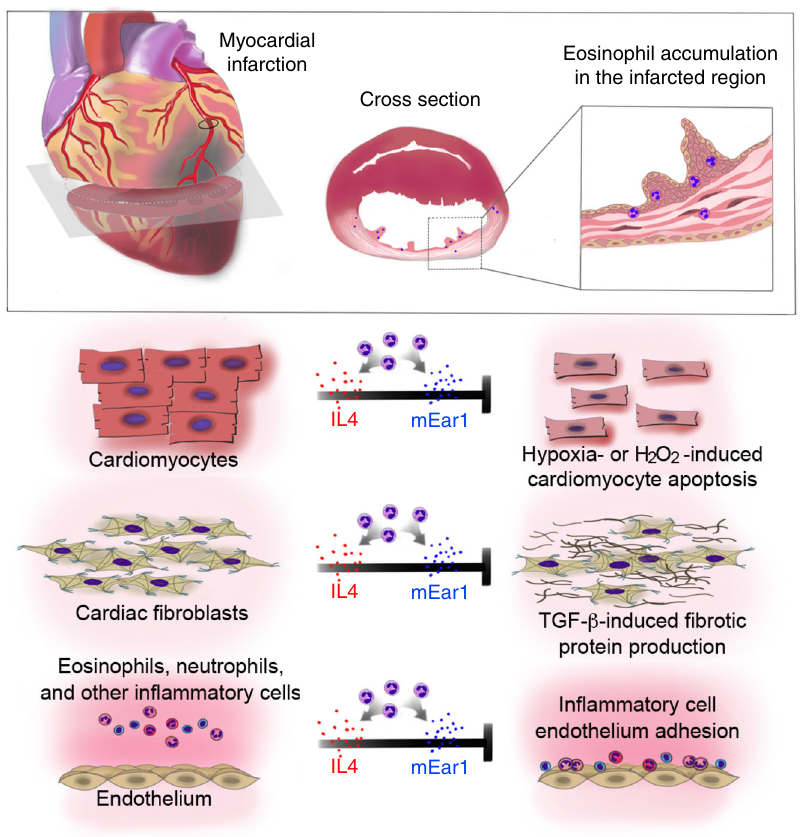
Fig. 7 EOS functions in post-MI heart. a Schematic illustration of EOS accumulation in the infarct area of mouse heart post-MI. b Summary of EOS function in protecting heart from MI-induced injury by producing Th2 cytokines (e.g., IL4), cationic proteins (mouse mEar1, human ECP and EOS-derived neurotoxin), or other untested molecules to reduce cardiomyocyte apoptosis, cardiac fi broblast activation and fi brotic protein synthesis, and in fl ammatory cell adhesion and infarct heart